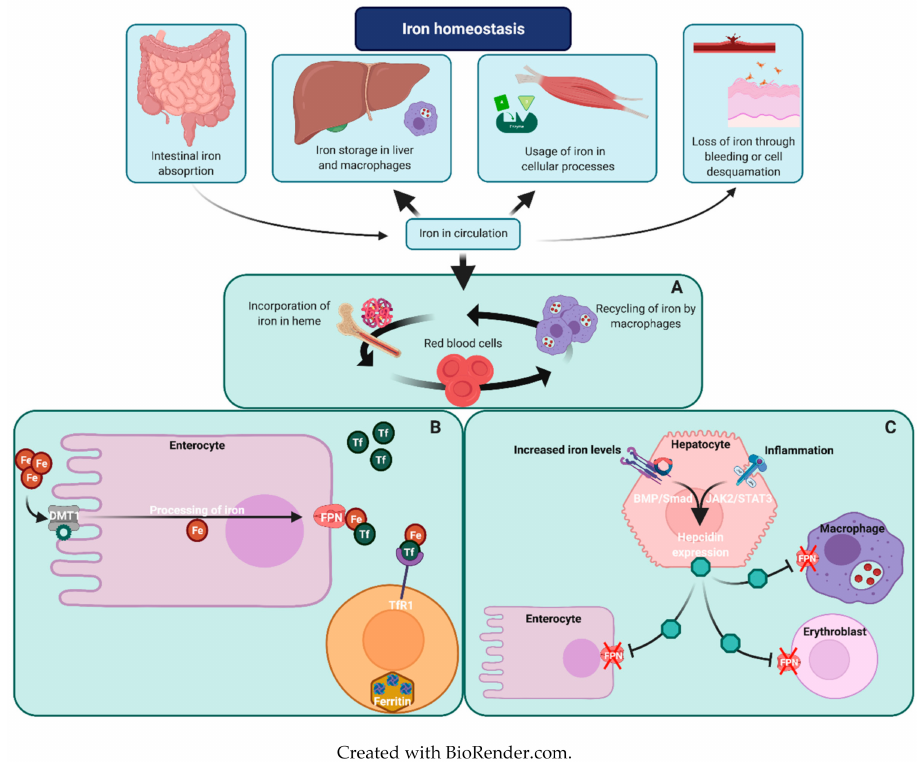
Figure 1. Simplified overview of iron homeostasis. Thickness of arrows reflects amount of iron per compartment. In humans, daily absorption of iron, as well as iron loss, is minimal. Most iron is either stored, used for cellular processes or is present in the erythroid compartment. ( A ) Iron recycling within the erythroid compartment. Iron is incorporated in hemoglobin and recycling of iron occurs due to splenic clearance of senescent red blood cells. ( B ) Iron absorption, transport and storage. Enteral absorption is facilitated by divalent metal transporter 1 (DMT1). Iron is processed and secreted to the circulation via ferroportin (FPN), the carrier protein through which stored iron is also secreted from within macrophages and hepatocytes. In the circulation iron binds to transferrin (Tf) and cellular uptake occurs upon binding of Tf to transferrin receptor 1 (TfR1). Iron is primarily stored as ferritin within cells. ( C ) Hepcidin-ferroportin axis. Hepcidin expression is predominantly induced by the bone morphogenetic protein (BMP)/Smad signaling pathway, upon increased serum iron levels. Alternatively, the Janus kinase 2/Signal Transducer and Activator of Transcription 3 (JAK2/STAT3) pathway is activated upon inflammation through interleukin-6 (IL-6). Hepcidin blocks FPN-dependent iron export, and induces FPN degradation, resulting in a limitation of iron absorption and iron efflux from body iron storages